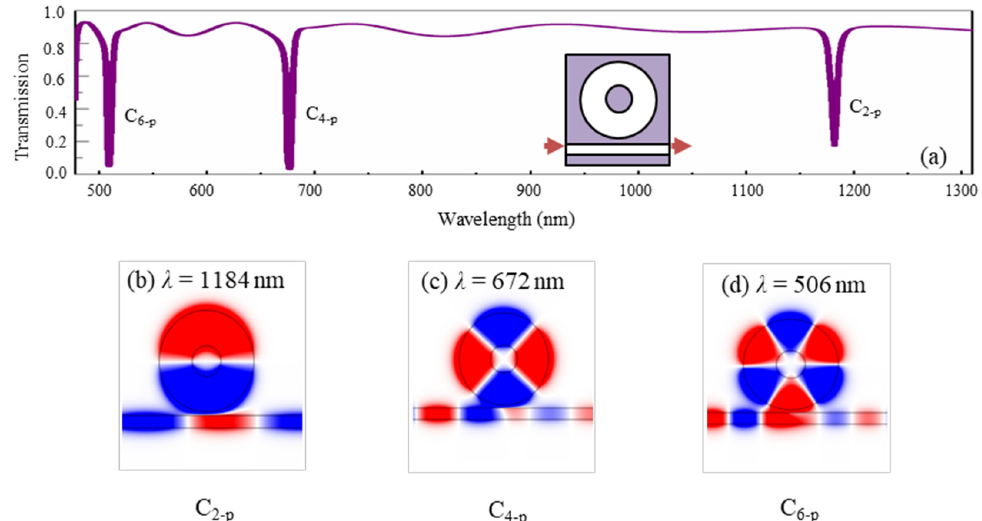
Figure 4. ( a ) The transmission spectrum of the metal-core circular cavity coupled with a straight waveguide, and the H z -field distributions at the transmission dips of ( b ) C 2-p with λ = 1184 nm, ( c ) C 4-p with λ = 672 nm, and ( d ) C 6-p with λ = 506 nm.